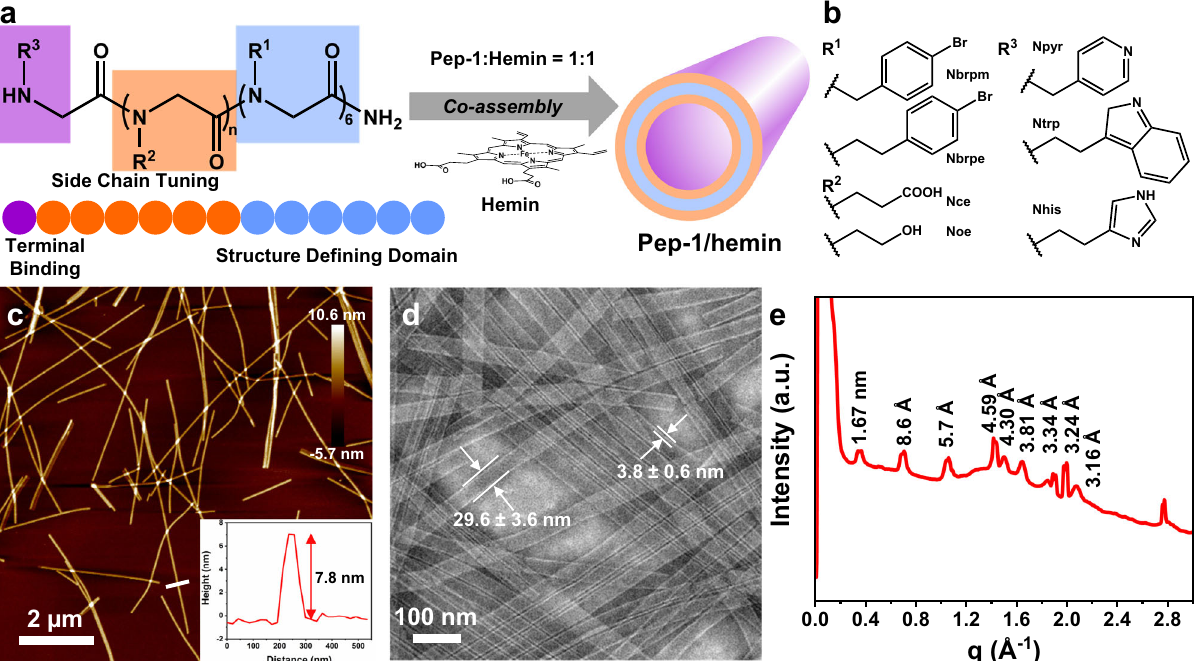
Fig. 1 Peptoid sequences and their assembled nanotube structures. a Molecular and schematic representations of peptoid sequences and its co-assembly with hemin into nanotube morphology. b Side chain and terminal modi fi cations of peptoid sequences. c AFM image of showing the co-assembled nanotube structure of Pep-1 (R 1 = Nbrpm, R 2 = Nce, R 3 = Npyr, n = 6) and hemin. The inset shows the height the nanotube is around 7.8 nm. d TEM image showing the Pep-1/hemin nanotube with a width of 29.6 ± 3.6 nm and a wall thickness of 3.8 ± 0.6 nm based on at least 50 counts. e XRD spectrum of Pep-1/hemin nanotube. The value above each peak is calculated based on the equation d = 2 π / q